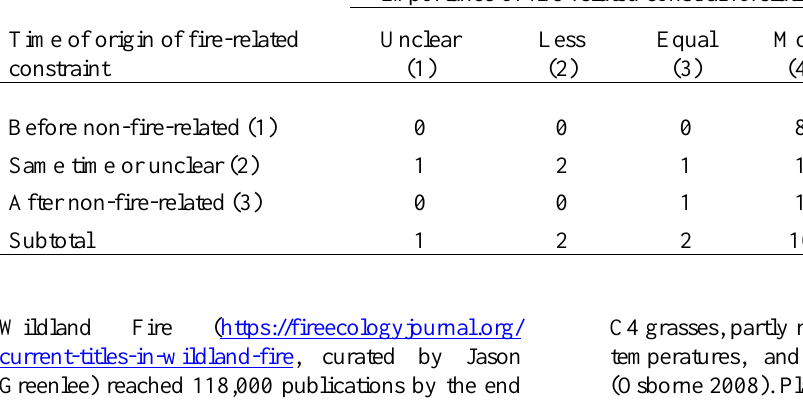
Table 1. Ranking of 21 paired sets of observations on botanical phenomena (Table A2) according to whether observed fire-related or non-fire-related constraints gave scientifically sounder explanations (five ranks) and the evolutionary sequence (three ranks) in which the fire-related and non-fire-related constraints occurred together with their